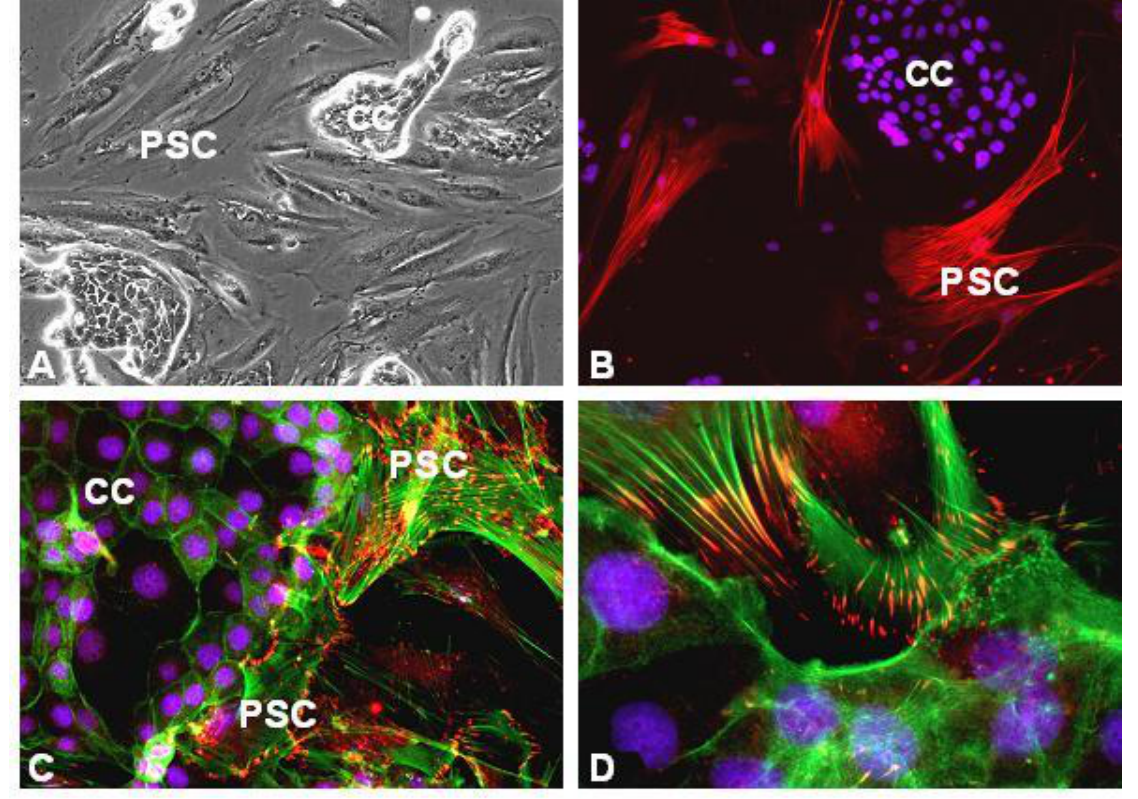
Figure 5. Microphotographs of PSC (isolated from PDA) in co-culture with primary pancreas carcinoma cells (ULA-PaCa). (a) phase contrast; (b) alpha-smooth muscle actin immunofluorescence (red); (c) vinculin, red-yellow, f-actin, green; (d) paxillin, red-yellow; f-actin, green. Cell nuclei are stained blue (Hoechst 33258). CC, panceas carcinoma cells (ULA-PaCa); PSC, pancreatic stellate